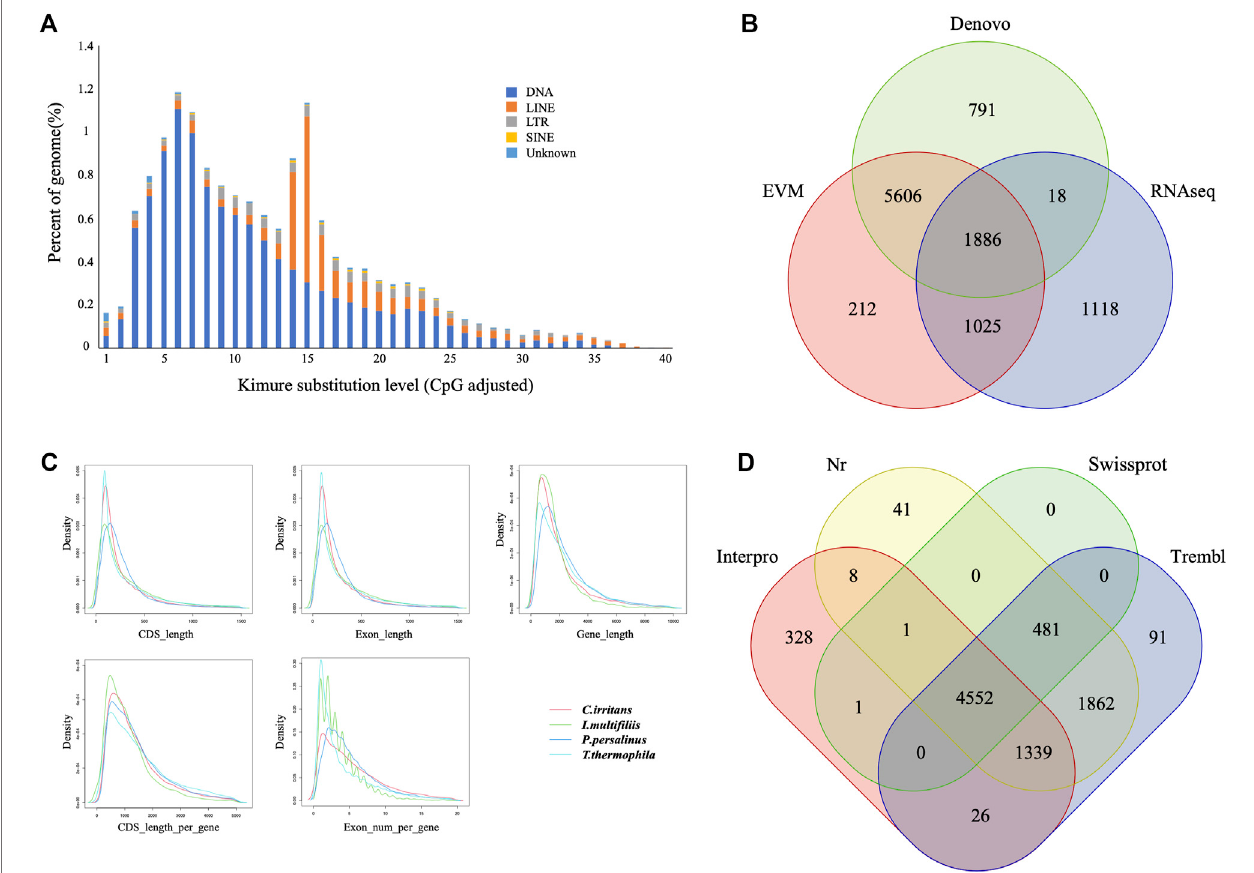
FIGURE2| Geneandrepetitiveelementannotationsofthe C.irritans genome. (A) Divergencedistribution ofTEsinthe C.irritans genome. (B) Venndiagramofthe number of genes with structure prediction based on different strategies. (C) Gene components distribution patterns among C. irritans and related species ( I. multi fi lii , P. persalinus , T. thermophila ). (D) Venn diagram of the number of functionally annotated genes based on different public databases.